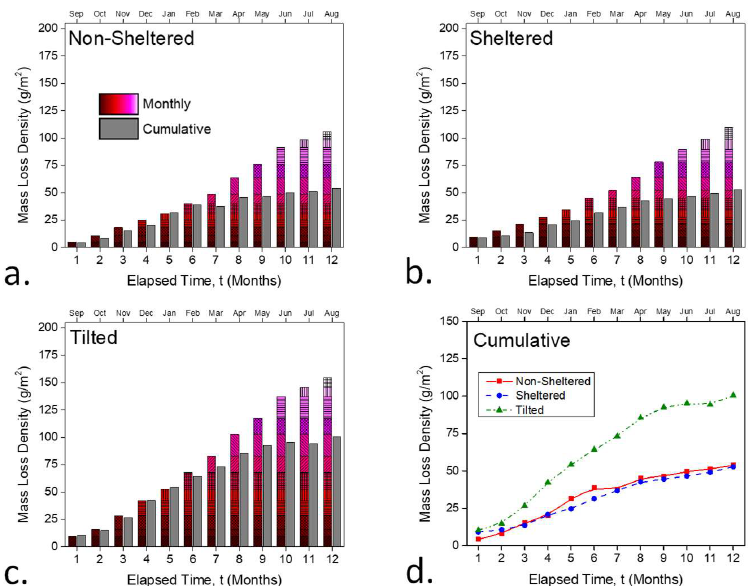
Figure 3. Mass Loss Density Results for the Wide steel reported for each condition. Non-Sheltered ( a ); Sheltered ( b ); Tilted ( c ); Overlay of all Wide cumulative results ( d ).